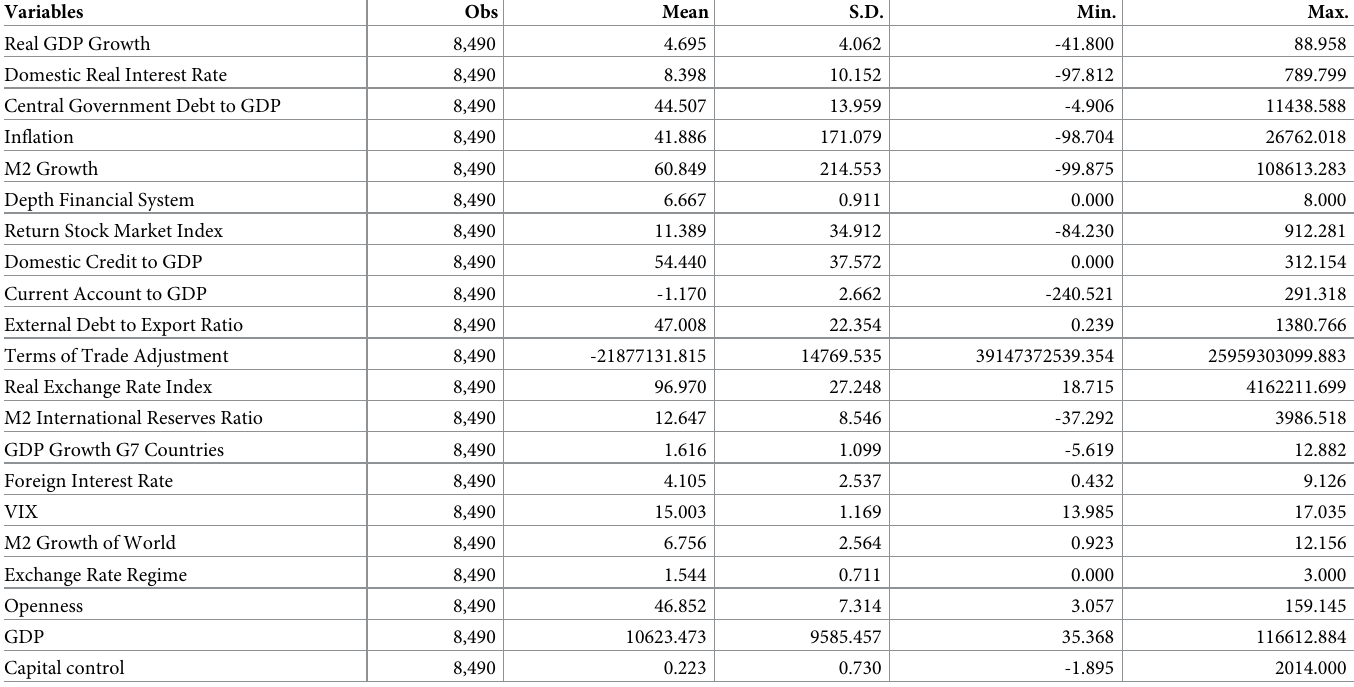
Table 4. Global summary